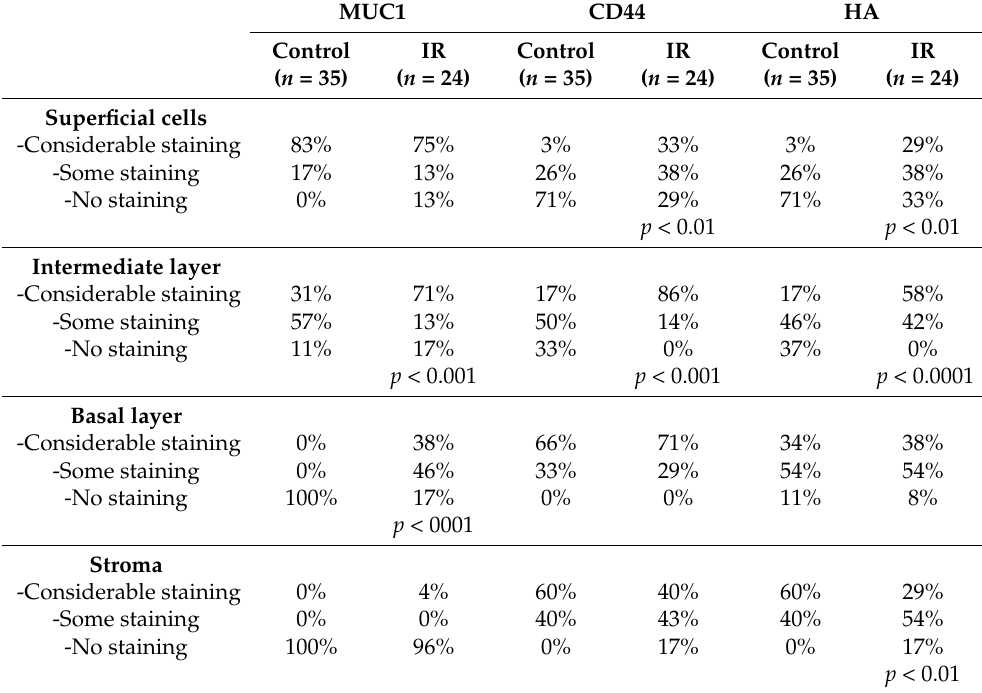
Table 2. The percentage for staining intensity of MUC1, CD44, and HA as considerable staining, some staining, and no staining are assessed in basal, intermediate, and superficial cell layers of oral epithelium and in stroma among control and irradiated groups. The statistical significance of staining intensity between controls and irradiated (IR) was tested using the Fischer-Freeman-Halton test.